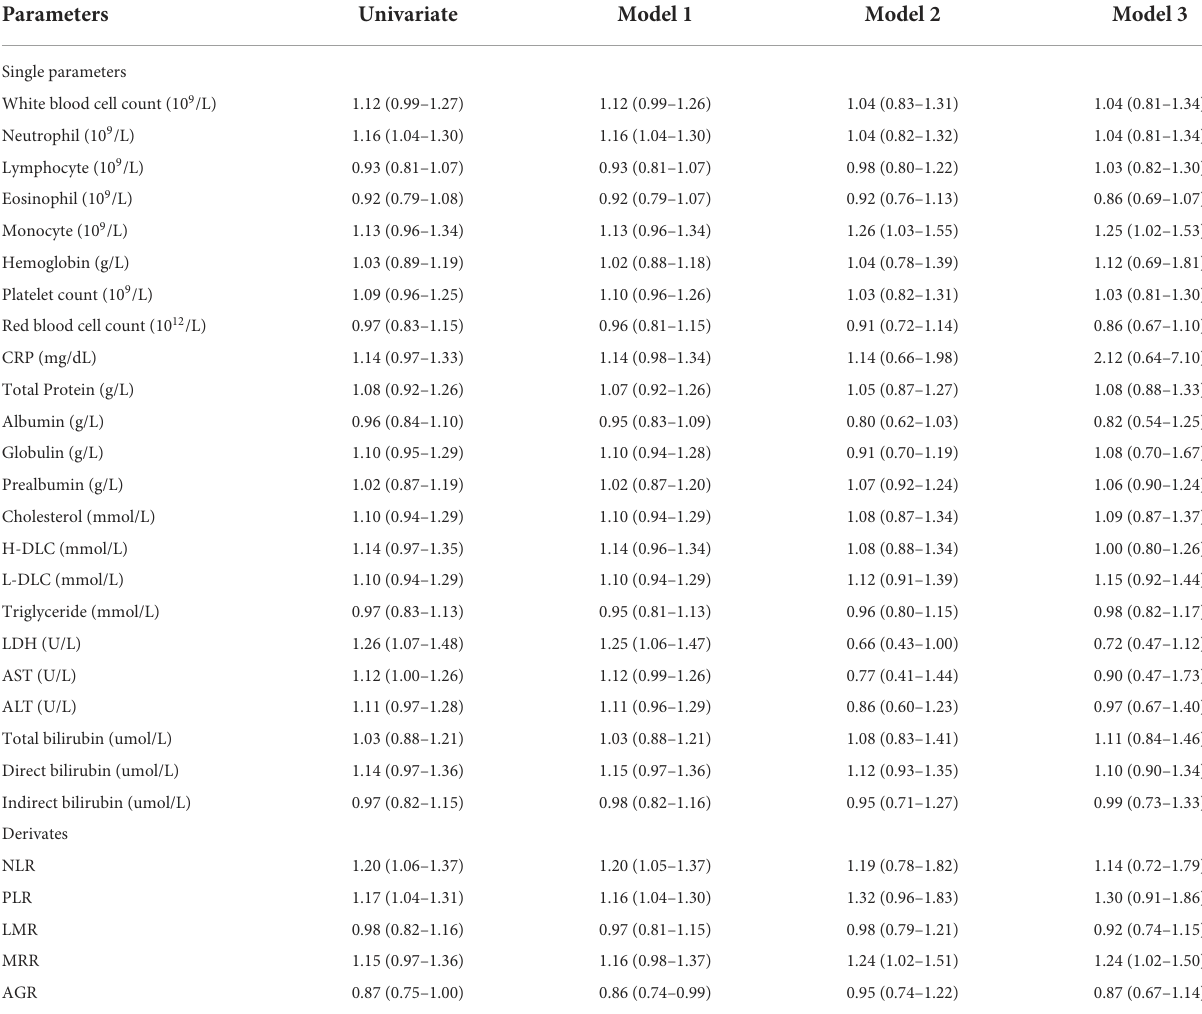
TABLE 2 Effect-size estimates of blood routine and biochemical parameters for mortality in the derivation